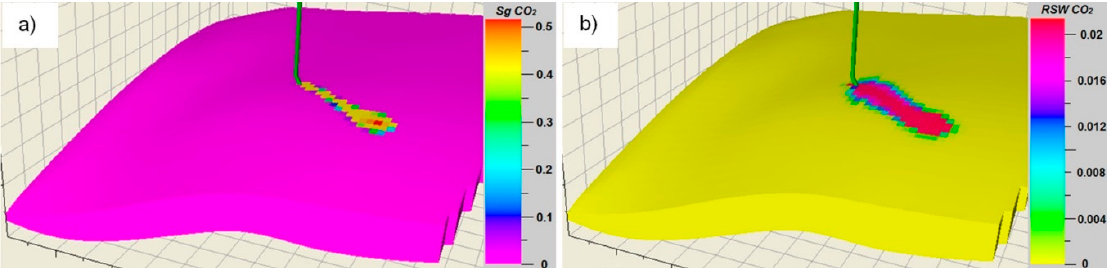
Figure 14. Changes in free CO 2 saturation—Sg ( a ) and dissolved CO 2 concentration—RSW ( b ) in the roof part of the injection layer after 25 years of injection.